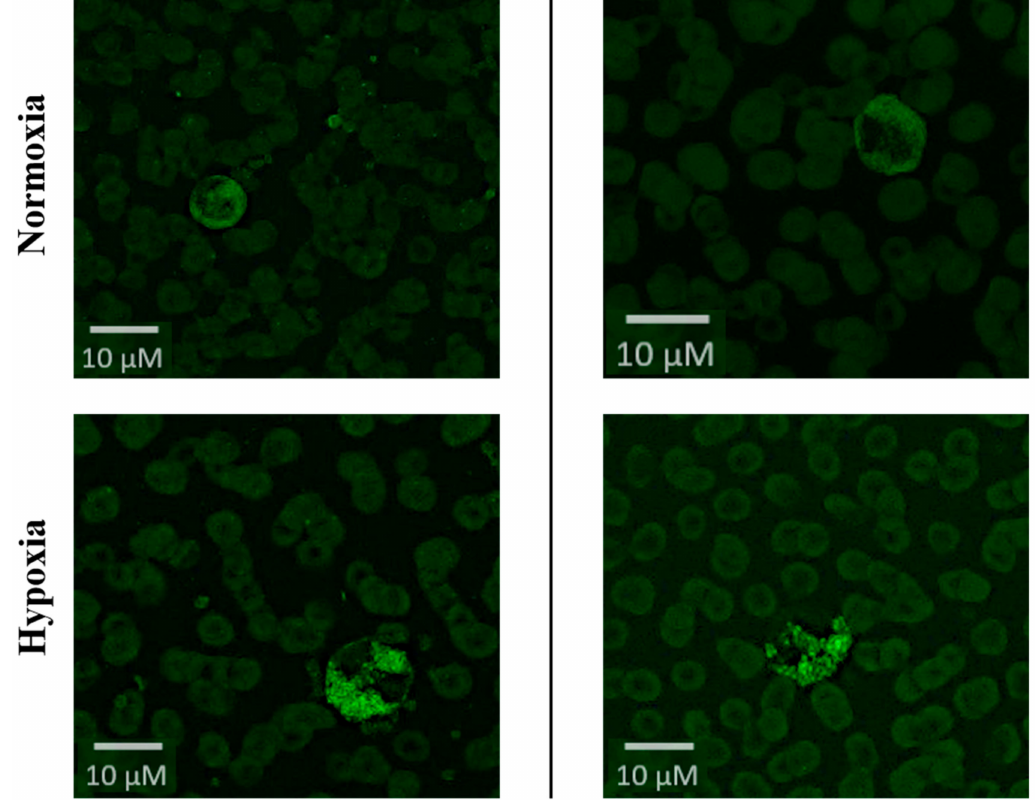
Figure 1. HIF-1 α protein visualization. Fluorescence microscopy from peripheral blood smears of 2 randomly chosen individuals at baseline conditions (Normoxia in Munich, 520 m a.s.l, upper part) and hypobaric hypoxia (after 24 h at Little Matterhorn summit, 3.883 m a.s.l., lower part) conditions using a primary mouse antihuman HIF-1 α antibody. Erythrocytes can be identified due to their homogenous size (approximately 8 µ m), central concavity, and typical non-fluorescent background staining pattern. All other cells with a size of 8–12 µ m can be categorized as HIF-1 α positive (entirely fluorescent cells), intermediate (partly fluorescent cells), or negative (nonfluorescent